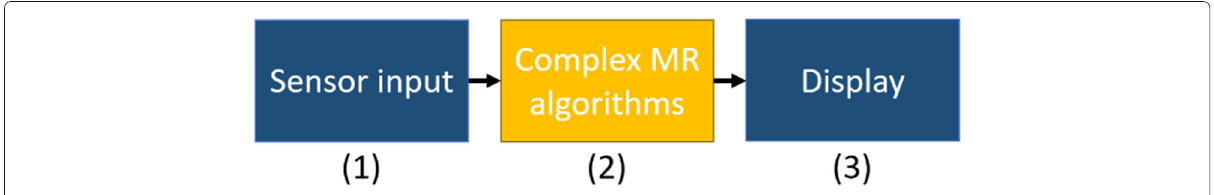
Fig. 2 MR application